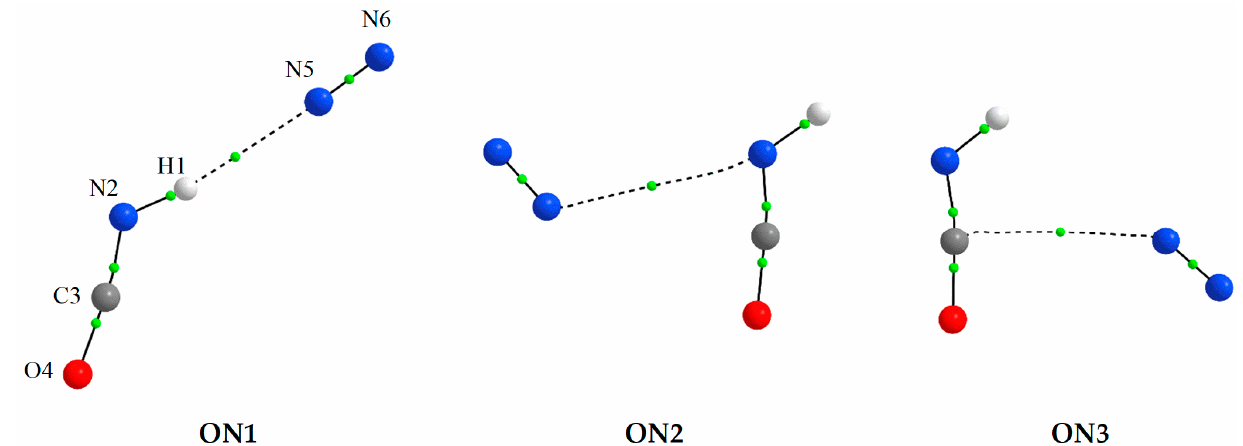
Figure 1. The MP2 optimized structures of the 1:1 HNCO · · · N 2 complexes. The positions of the bond (3, − 1) critical points derived from AIM calculations are shown by small green circles.